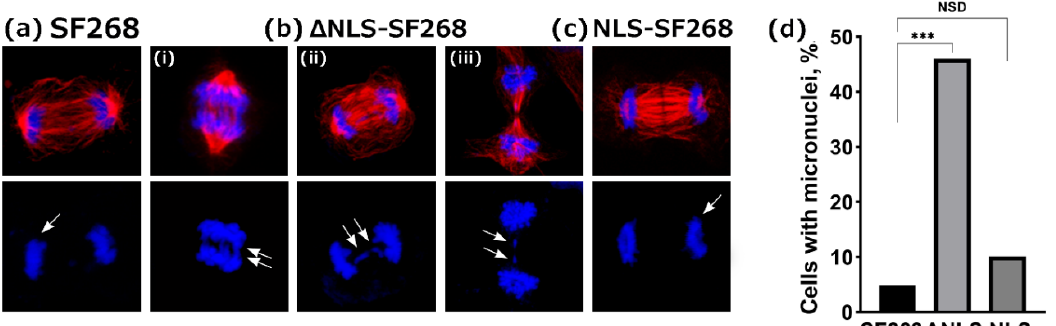
( f ) mitotic stage percentages. Bracketed bars in d and e represent the means and standard errors of measurements in 25–30 cells per cell line from each of 3 separate experiments with synchronized cells and in f, mitotic stage distribution of asynchronous cells ( n = 800 mitotic figures for each cell line from five di ff erent experiments). p values, based on x ± SE, are: ** ≤ 0.01, *** ≤ 0.001, **** ≤ 0.0001; NSD, no significant di ff erence.